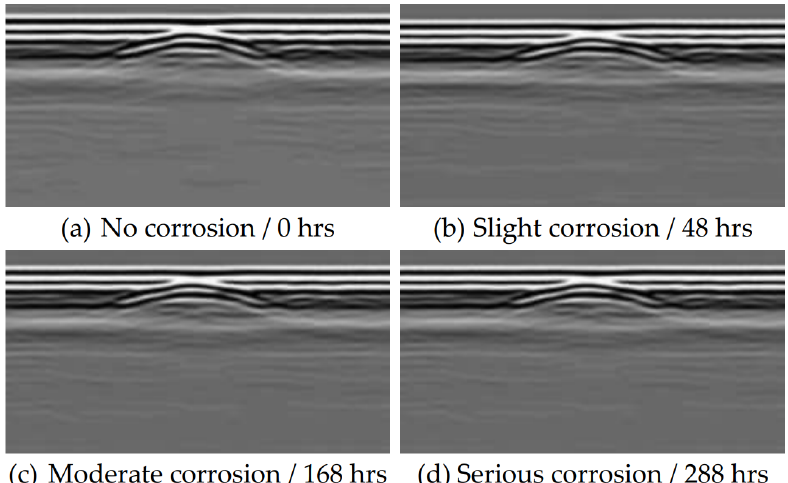
Figure 11. GPR Scanning Profile of Steel Bar Corrosion (thickness of 7 cm).